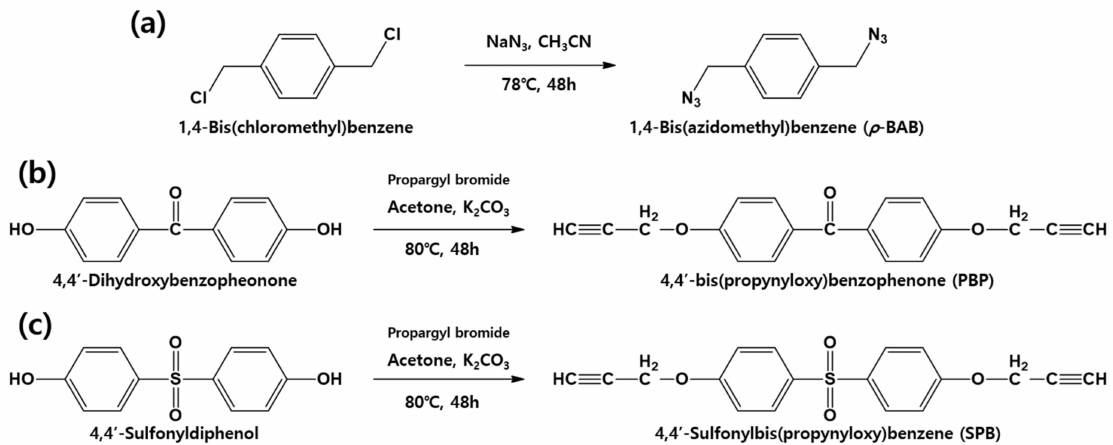
Figure 2. Reaction scheme of the p -BAB, PBP, and SPB: ( a ) p -BAB; ( b ) PBP; and ( c ) SPB.